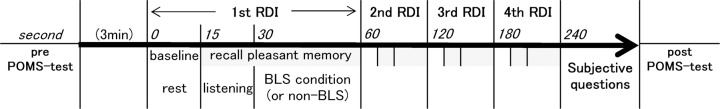
The design of the study.NIRS measurement procedure: Thick line indicates the NIRS measurement The POMS test was administered before and after the NIRS measurement.The baseline [oxy-Hb] level was the average value during the last 5 s of each 15-s rest period. Listened to the original script and recalled it for 15 s either accompanied by (BLS condition) or not accompanied by (non-BLS condition) BLS, two times each.Each subject was asked the subjective questions immediately after each of four RDI sessions.